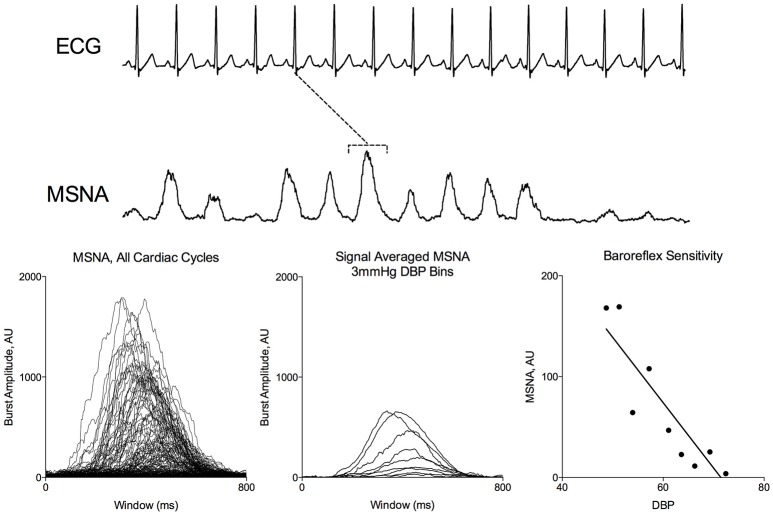
Signal Averaged Analysis of MSNA during Modified Oxford. MSNA activity corresponding to each ECG R peak (dotted line) were binned according to DBP. Average integrated MSNA was plotted for each 3 mmHg pressure bin.